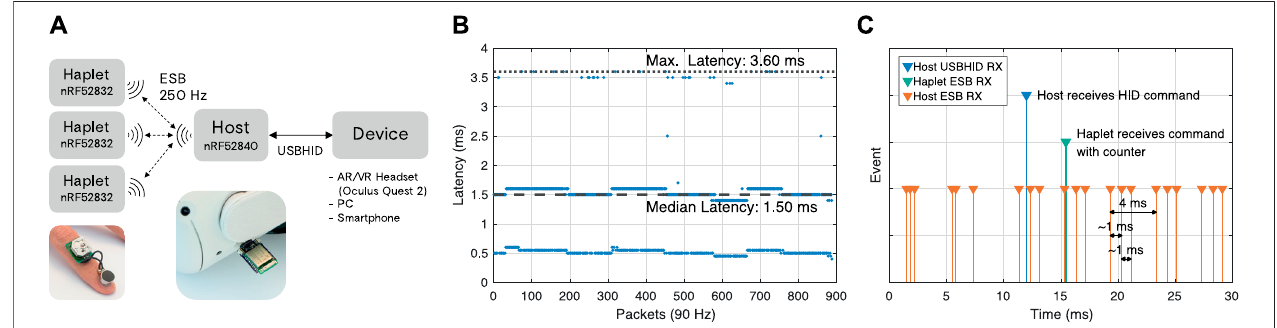
FIGURE2| Haplets ’ low-latencywirelesscommunicationarchitecture. (A) Each Hapletcommunicates usingtheEnhanced ShockBurst(ESB) protocolwithahost microcontroller that receives command from a host device using USB HID. Commands are updated at the rate of 250 Hz. (B) Latency, as de fi ned by the time the host microcontroller receives a command from the host device to the time a Haplet receives the command, is shown over a 10 s interval. The maximum latency and median latency is3.60 and 1.50 milliseconds, respectively. (C) Events received from ourlogic analyzer showing ourtimeslot algorithmmomentarilyadjustingthe period for sending packets over ESB to prevent radio collisions between